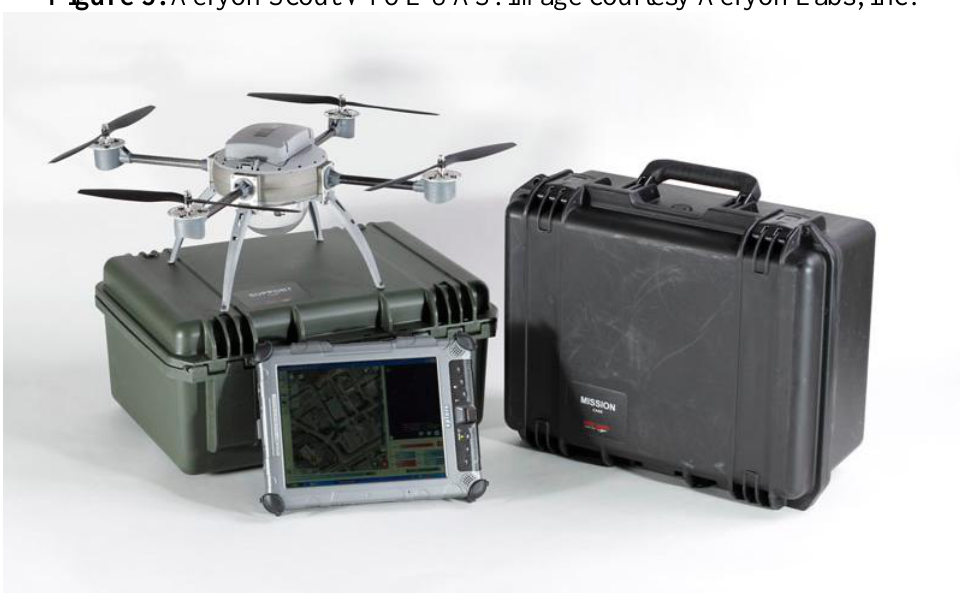
Figure 5. Aeryon Scout VTOL UAS. Image courtesy Aeryon Labs,